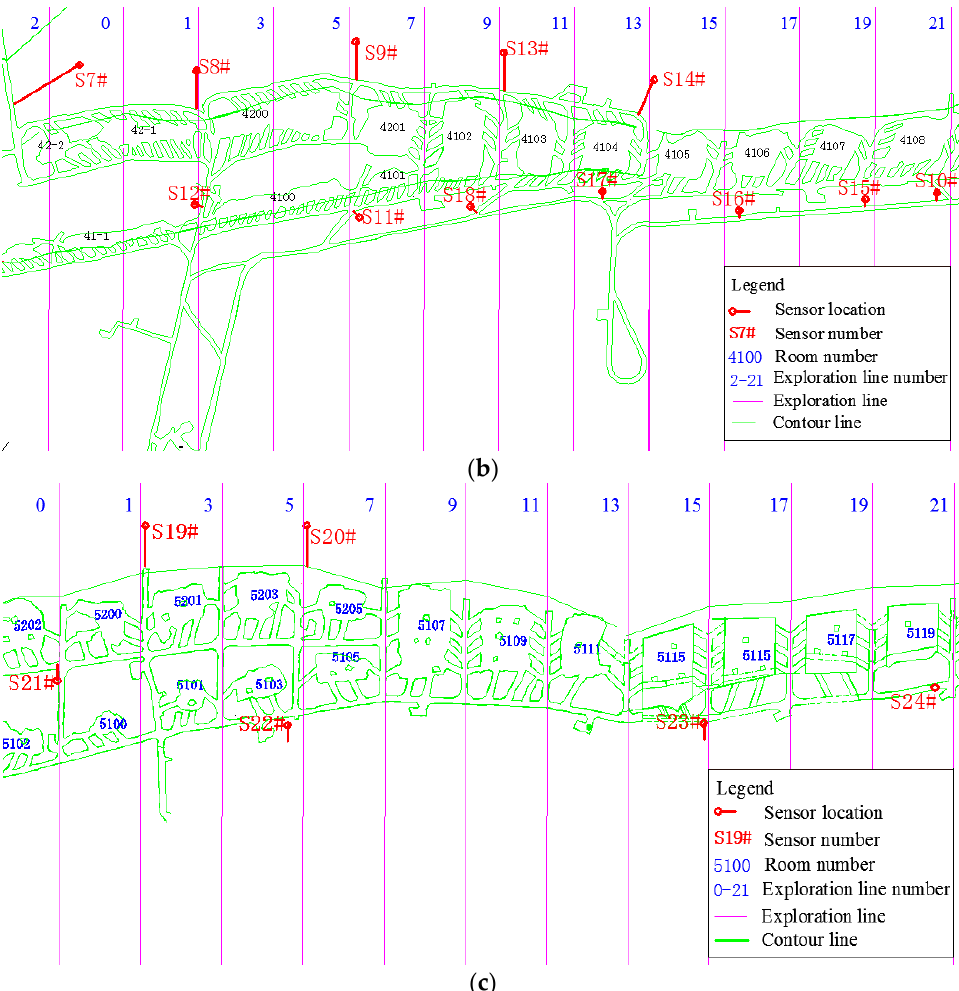
Figure 3. Diagrams of sensor locations: ( a ) the locations of sensors in the +955 m level; ( b ) the locations of sensors in the +905 m level; ( c ) the locations of sensors in the +855 m level.